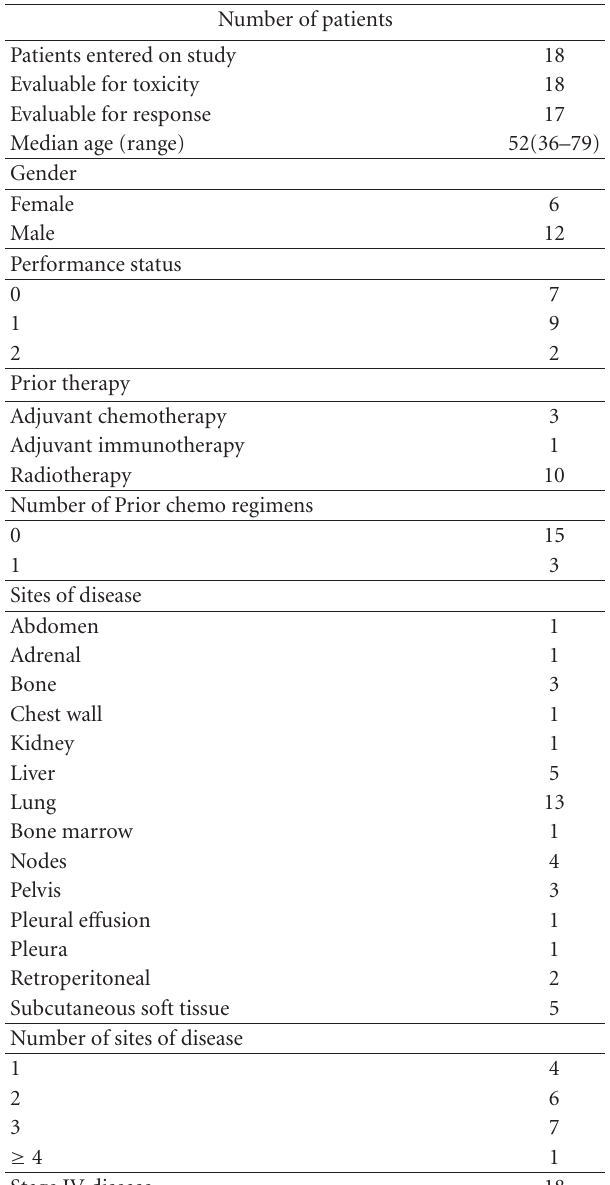
Table 1: Patient characteristics ( n = 18 patients). Table 2: Histology ( n = 18